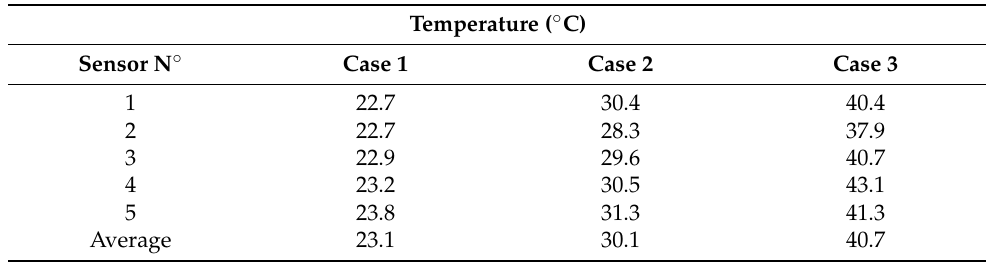
Table 2. Measurement of the bushing temperature at various points to check for uniform temperature distribution; the markings of the measurement points are as shown in Figure 4a.